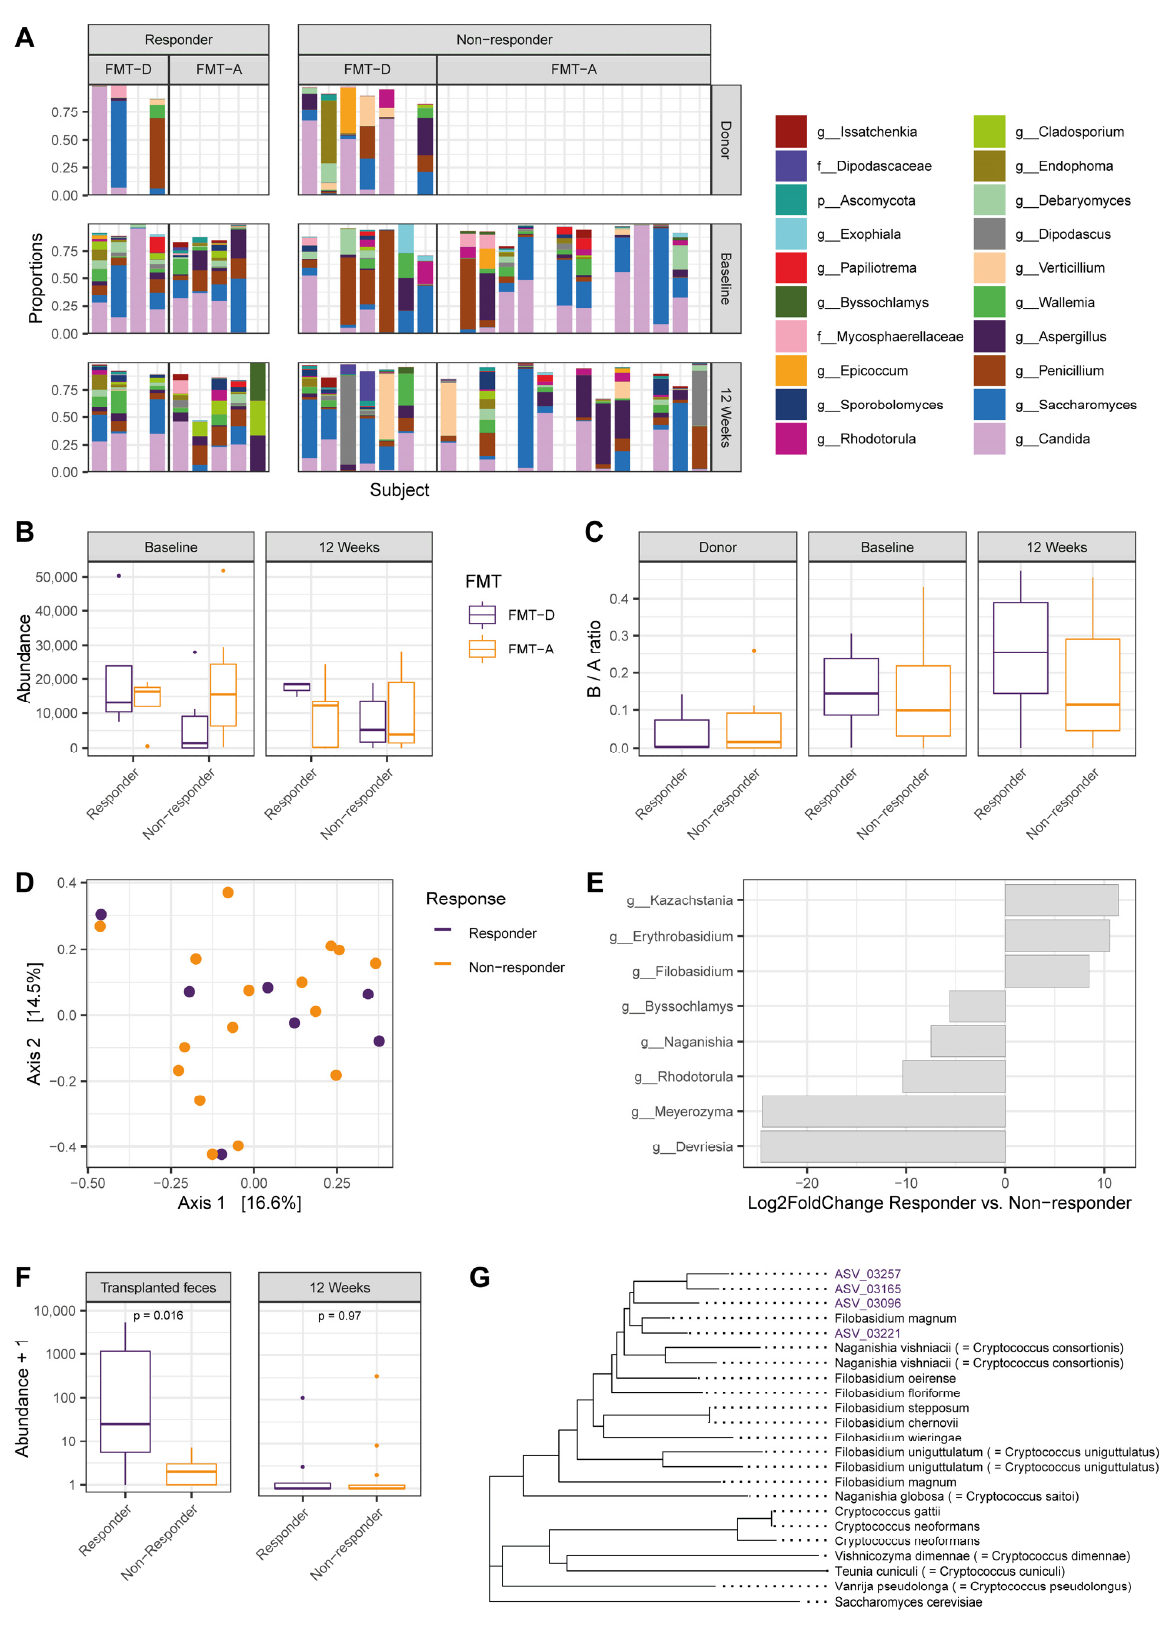
Figure 1. Filobasidium spp. abundance in donor material is associated with positive response to fecal microbiota transfer (FMT). ( A ) Internal transcribed spacer 1 (ITS1)-based mycobiome composition